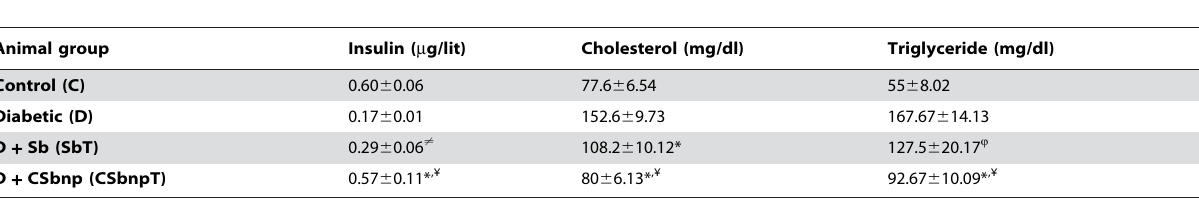
Table 1. Effect of Sb and CSbnp on serum insulin, cholesterol and triglyceride levels in diabetic rats.